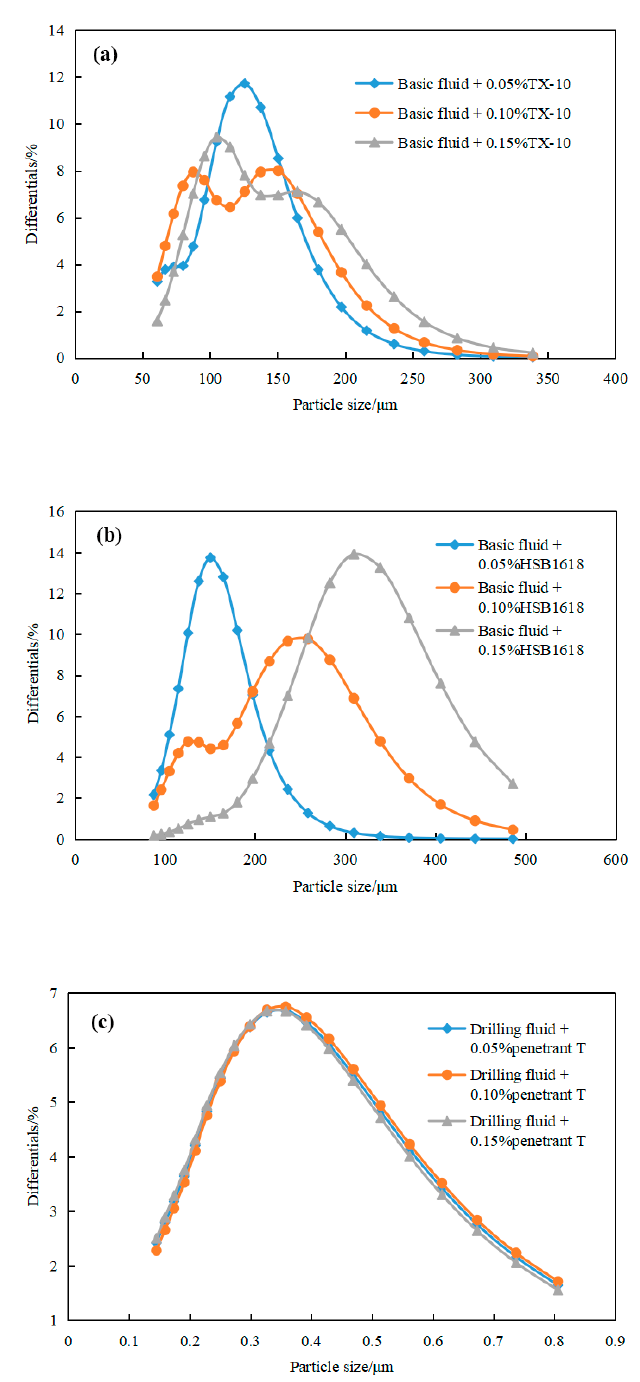
Figure 5. The particle size of the suspended rock powder in ( a ) basic fluid + TX-10, ( b ) basic fluid + HSB1618 and ( c ) basic fluid + penetrant T.